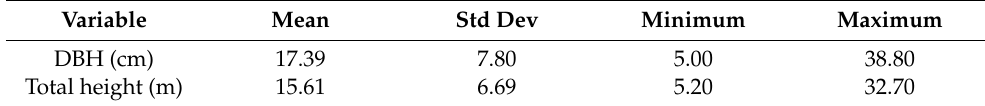
Table 1. Descriptive statistics of forest measurements.